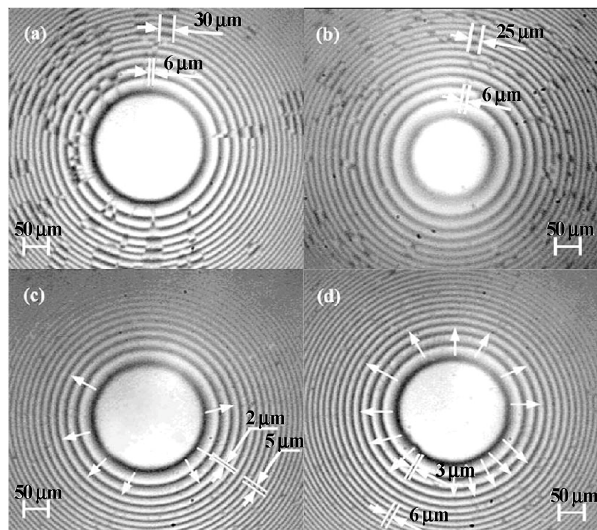
Fig. 22 Microbubbles in electrical field observed by Luo et al. by using different lubricants, (a) glycerin, 6 V; (b) glycol, 5 V; (c) hexadecane, 9 V; and (d) liquid paraffin, 7 V [95]. Copyright 2008, Springer Science+Business Media, LLC.